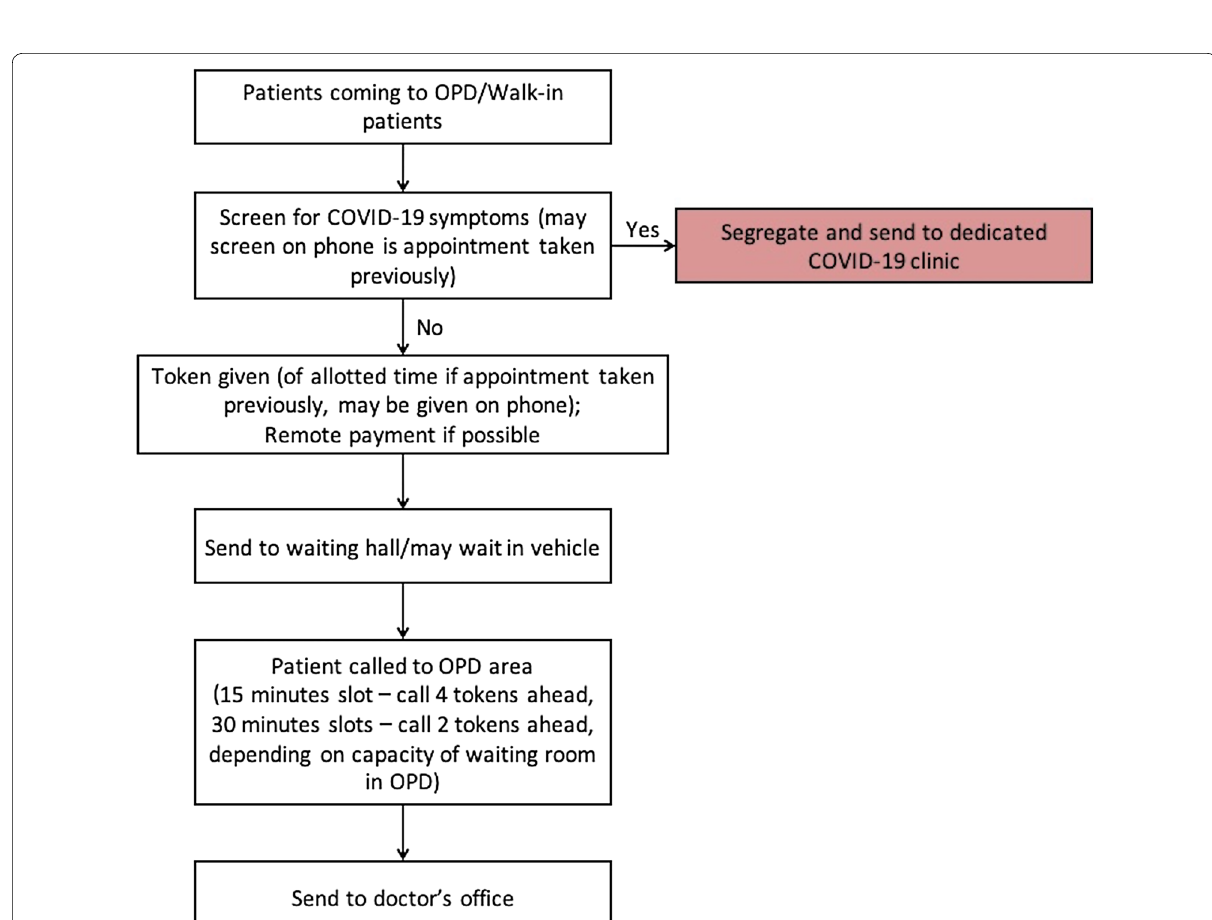
Fig. 2 Proposed algorithm for management of in‑person outpatient clinic